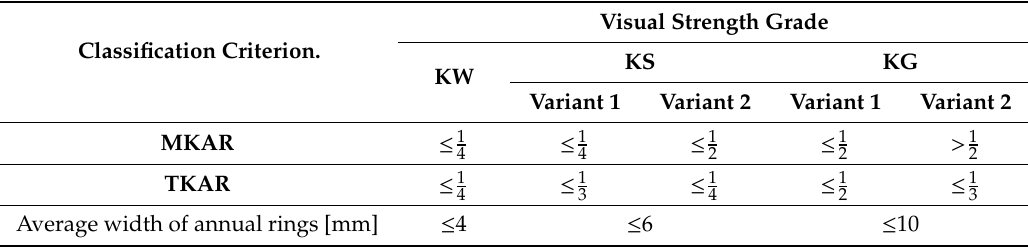
Table 1. Knot area ratio and average width of annual rings for individual visual strength grades according PN-D-94021:2013.